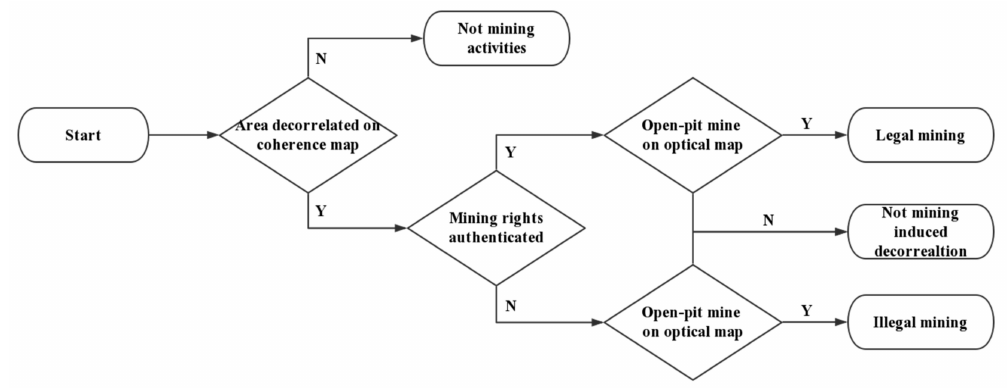
Figure 3. Workflow for identifying illegal mining using overlaid